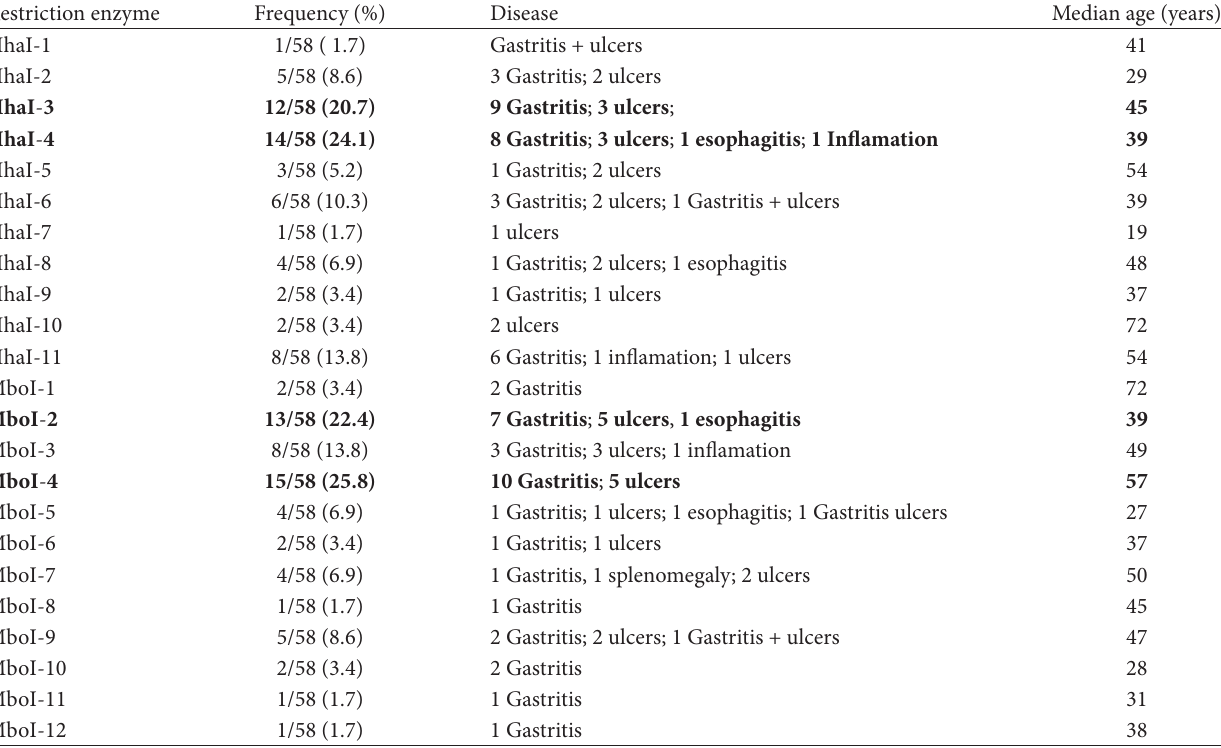
T 4: Use of the Restriction Fragment Length Products (RFLP) technique for genotyping the positive H. pylori PCR products using restriction enzymes ( HhaI and MboI